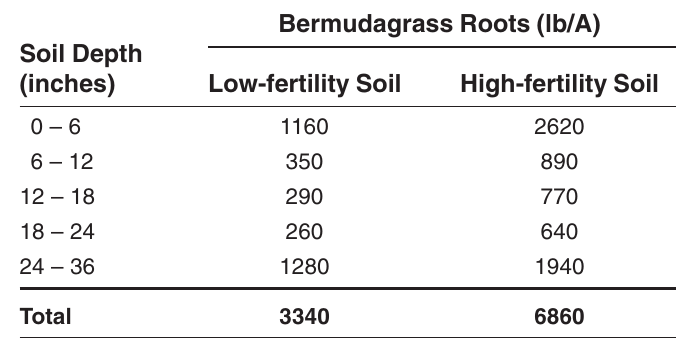
The Influence of Soil Fertility on Rooting Depth of Coastal Bermudagrass[9] Bermudagrass Roots